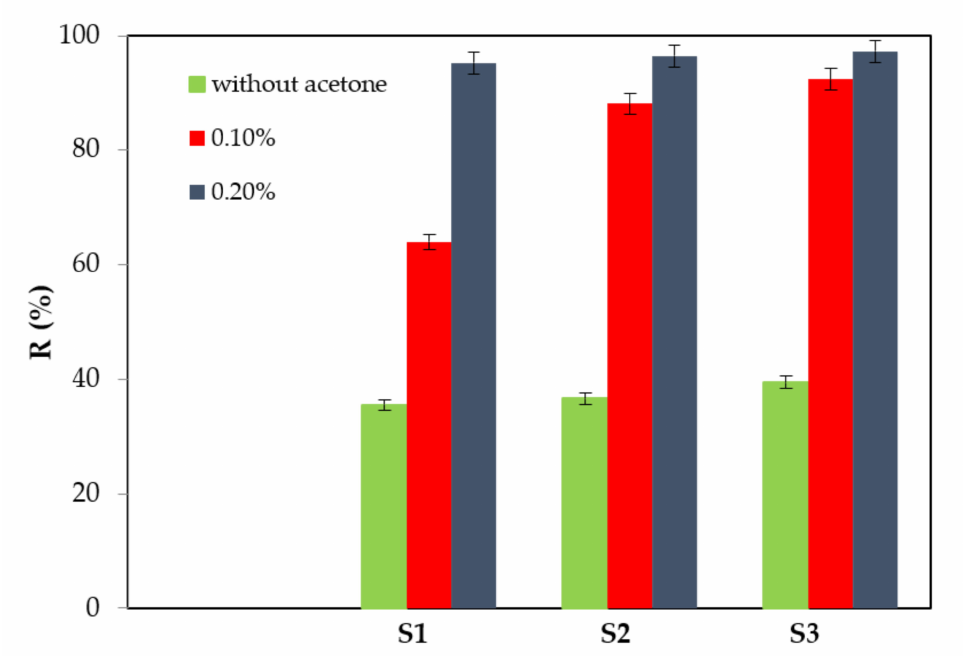
Figure 7. Effect of photosensitizer concentration on the MB